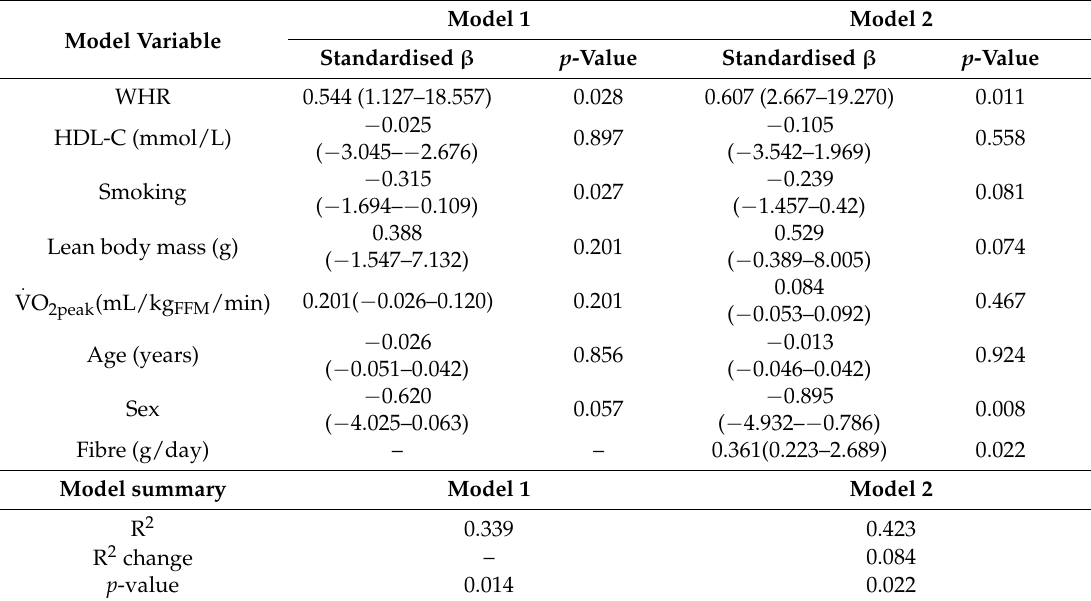
Table 3. Hierarchical multiple regression coefficients for the variables included in each model (circulating IL-22 levels as the dependent variable).